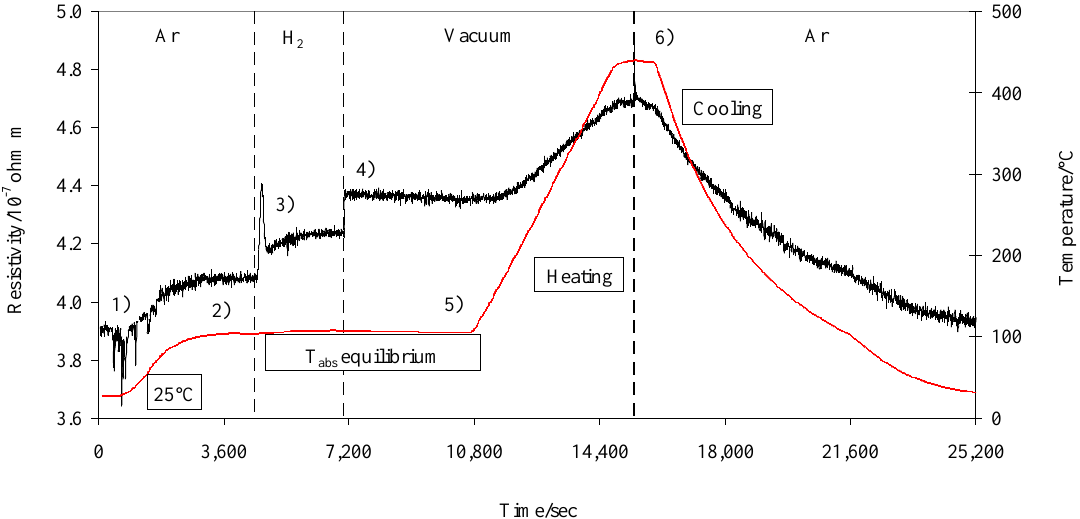
Figure 2. Resistivity and temperature during a typical impedance measurement.